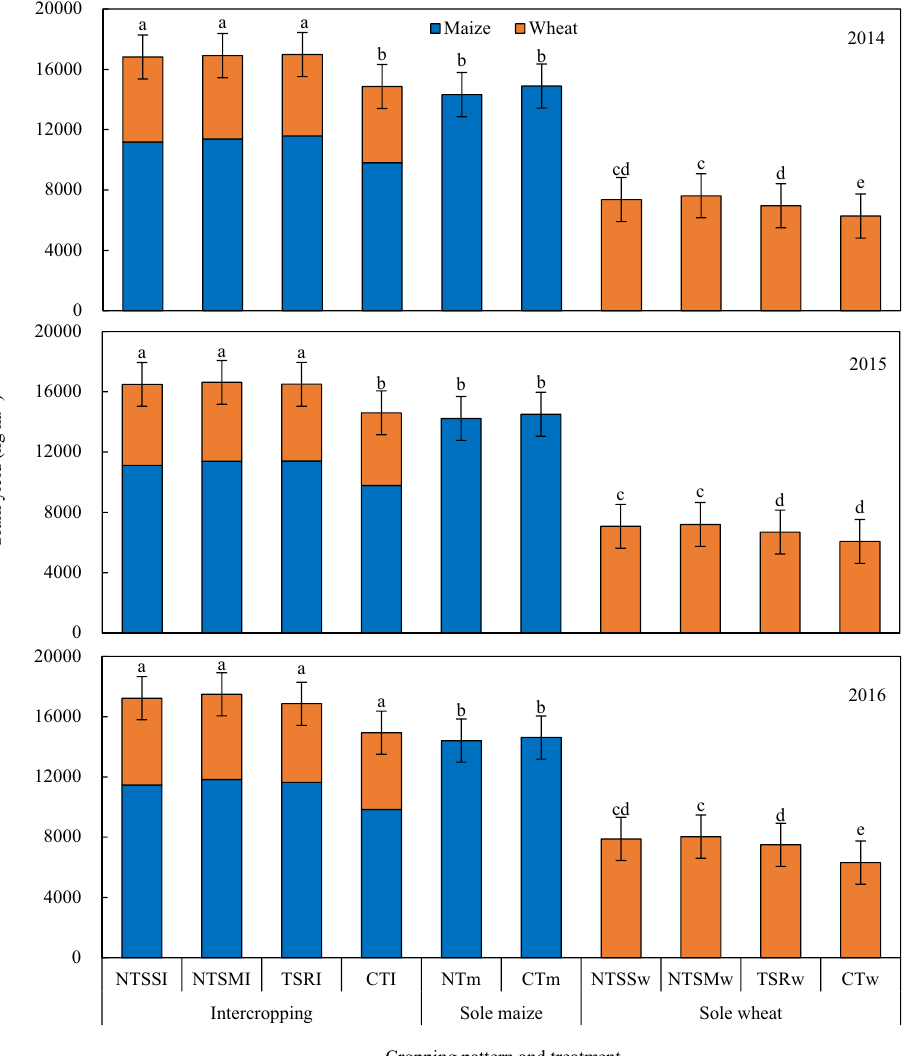
Figure 1. Grain yield of maize and wheat as affected by straw returning and film mulching in sole-crop and intercropping patterns in 2014, 2015, and 2016. Descriptions of treatment abbreviations are in Table 4. Different letters indicate significant differences ( P ≤ 0.05) among treatments within a year. Error bars indicate standard errors of the means (n =